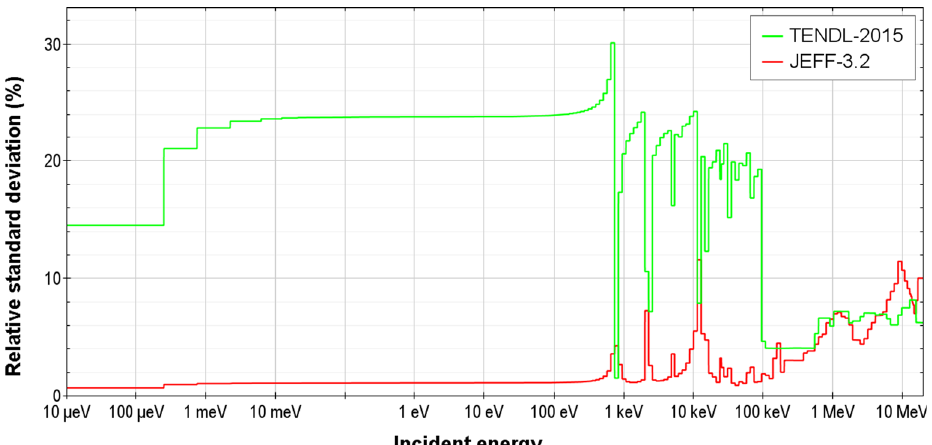
Fig. 6. Relative uncertainty of the 209 Bi ( n,n ) cross section from different nuclear data libraries as a function of incident neutron energy.